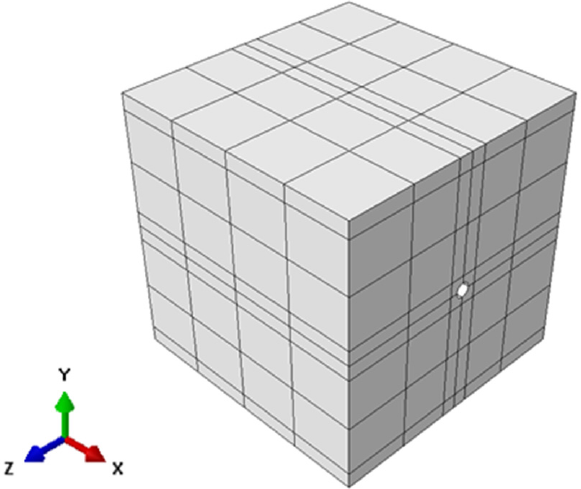
Figure 2. Geometric part—concrete box.